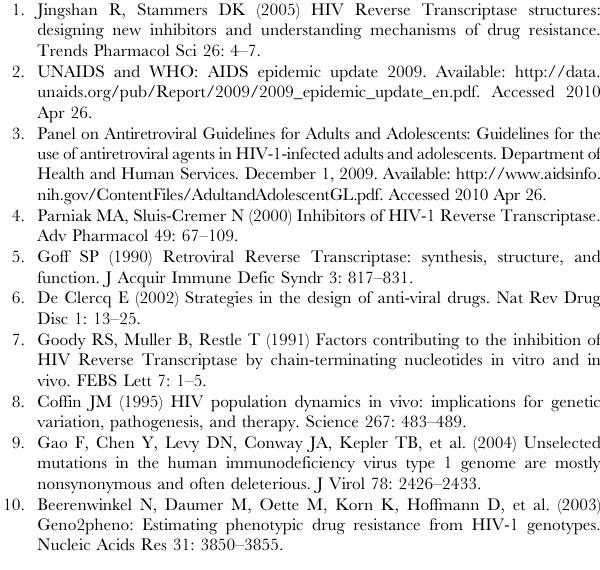
Table S1 List of 58 molecular descriptors used to characterize molecular properties of NRTIs for proteochemometric modeling of HIV drug